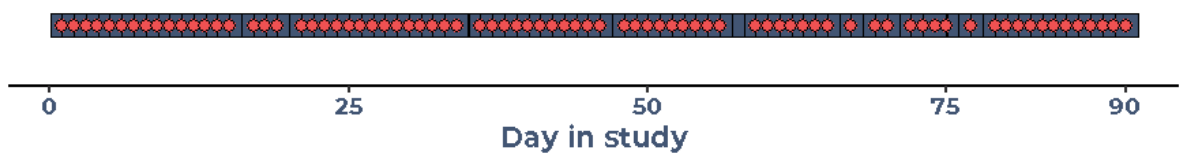
Figure 6. Engagement of case study 1 over 90 study days.